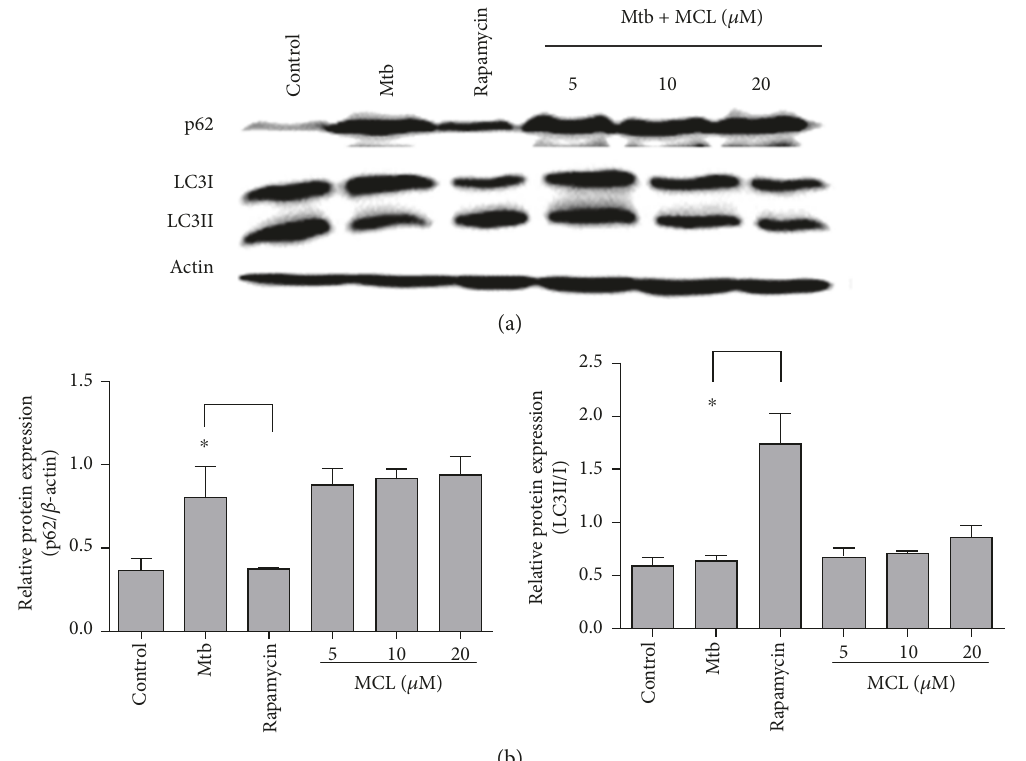
Figure 7: MCL has little impact on autophagy pathway. Raw264.7 cells (1 × 10 6 /well) were plated in 6-well plates overnight. Four hours after Mtb infection, cells were treated with or without MCL (10 μ M) or rapamycin (1 mg/ml) for 12 hr. The LC3I, LC3II, and p62 were detected by Western blot (a). The bar graphs showed the statistical results for the ratio of LC3II/LC3I and p62 expression (b). Data are shown with the means ± SD ( n ≧ 3 ). ∗ p < 0 05